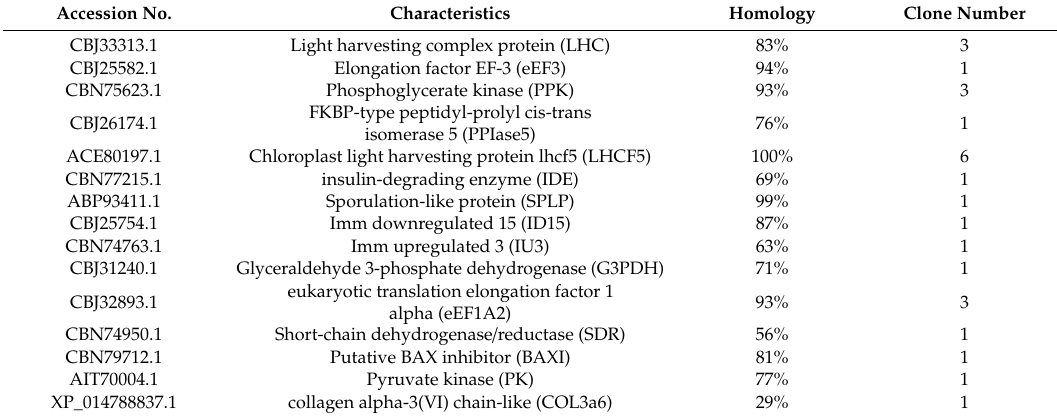
Table 4. BLAST analysis of yeast two-hybrid results using SjAUREO as bait to screen the WL treated cDNA